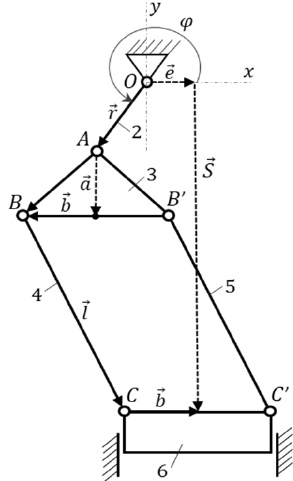
Figure 1. Lever Stephenson mechanism of crank